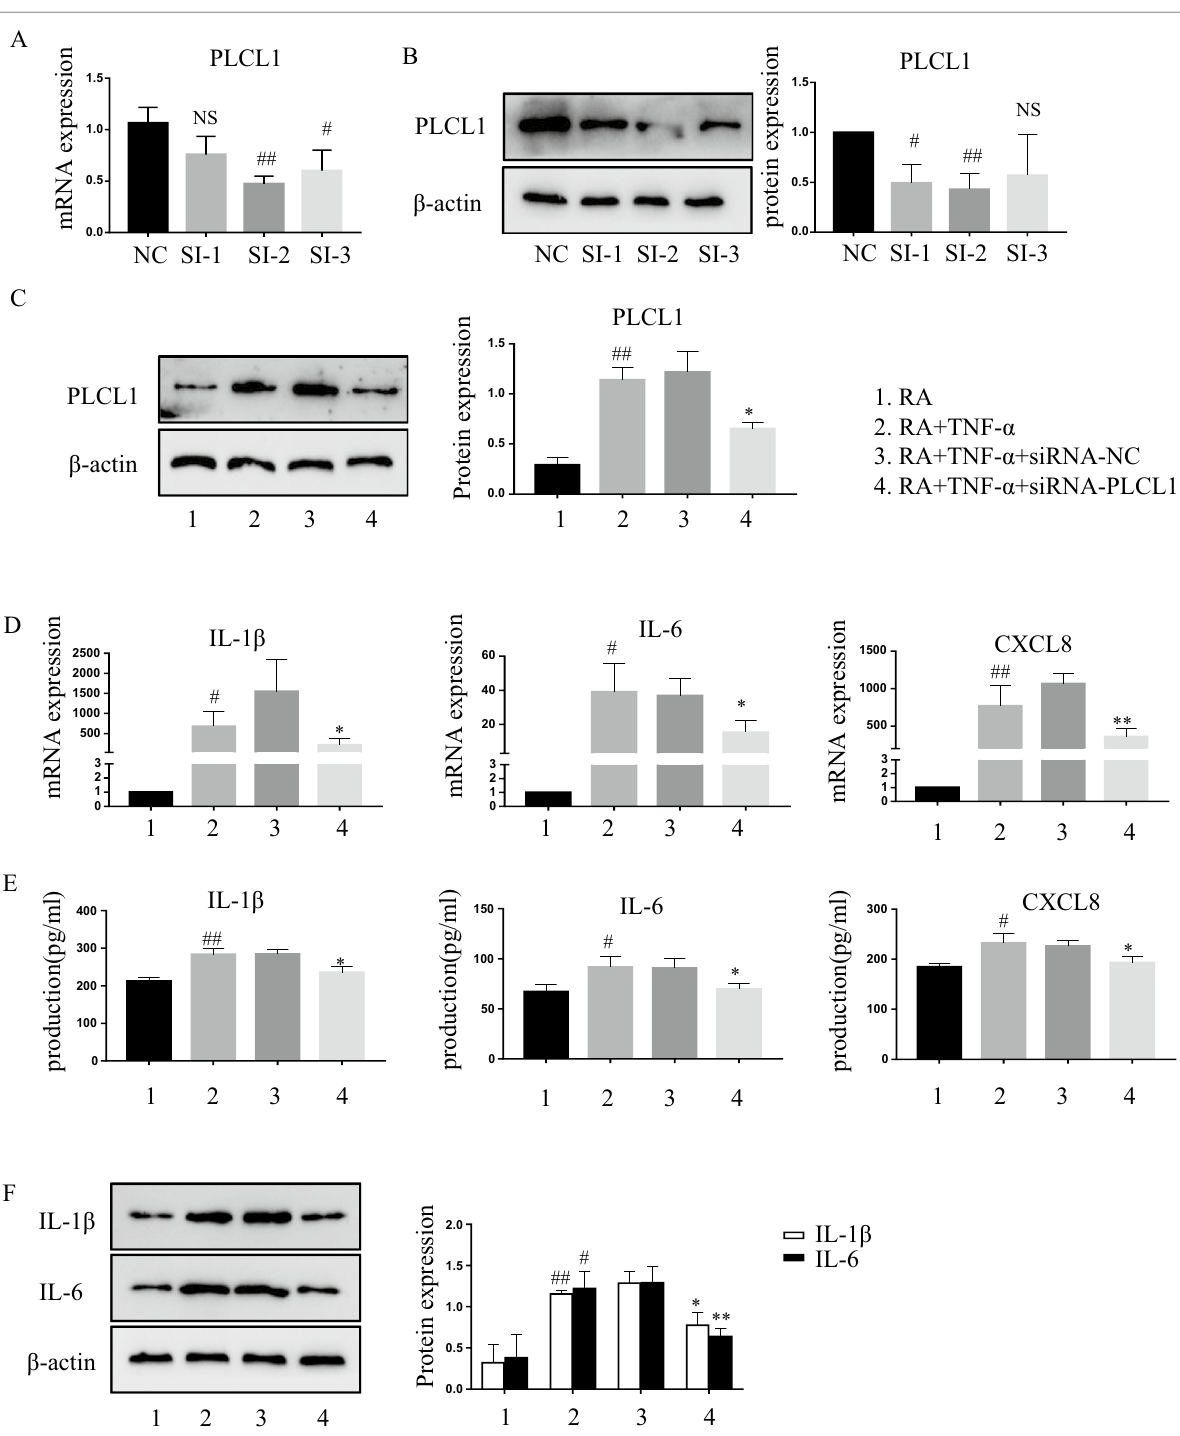
Fig. 3 Effect of PLCL1‑siRNA inhibited FLS Expressing inflammatory cytokines. a , b Detecting transfection efficiency of the three transfected strands in RA FLS by RT‑QPCR and WB. c The level of PLCL1 protein in 10 ng/ml TNF‑α‑incubated RA FLS were analyzed by WB, after using PLCL1siRNA. d The mRNA level of IL‑6, CXCL8 and IL‑1β was analyzed by RT‑QPCR in TNF‑α‑incubated in RA FLS after using PLCL1siRNA. e ELISA was used to detect the production of IL‑6, CXCL8 and IL‑1β in TNF‑α‑incubated RA FLS supernatants after using PLCL1‑siRNA. f The protein level of IL‑6 and IL‑1β was analyzed by WB in TNF‑α‑incubated in RA FLS after using PLCL1‑siRNA. (Compared with the RA group # P < 0.05, ## P < 0.01; compared with the negative control group * P < 0.05, ** P <